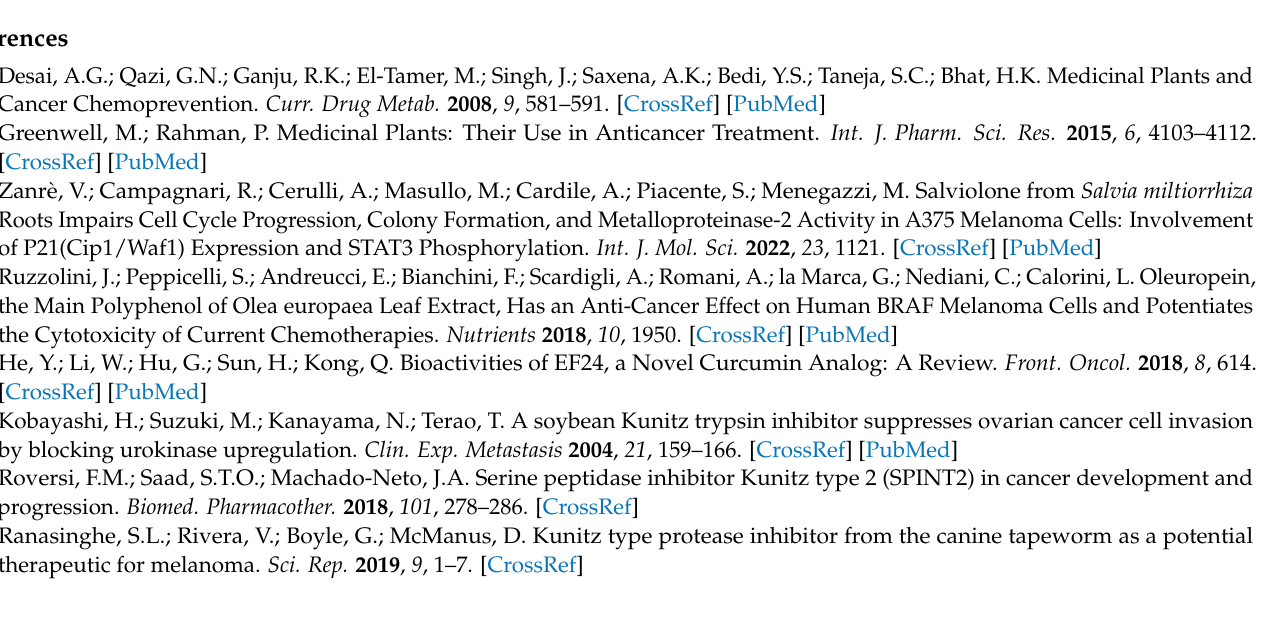
Figure S3: Molecular exclusion chromatography of EcTI; Figure S4: High-performance liquid chro- matography of EcTI; Figure S5: Electrophoresis gel (representative fractions of the EcTI isolation steps); Figure S6: Analysis of mycoplasma in melanoma cells; Figure S7: Cell viability by Presto Blue; Figure S8: Melanoma cell morphology; Figure S9: ROS production; Figure S10: Apoptosis of human melanoma cells treated with EcTI for 24